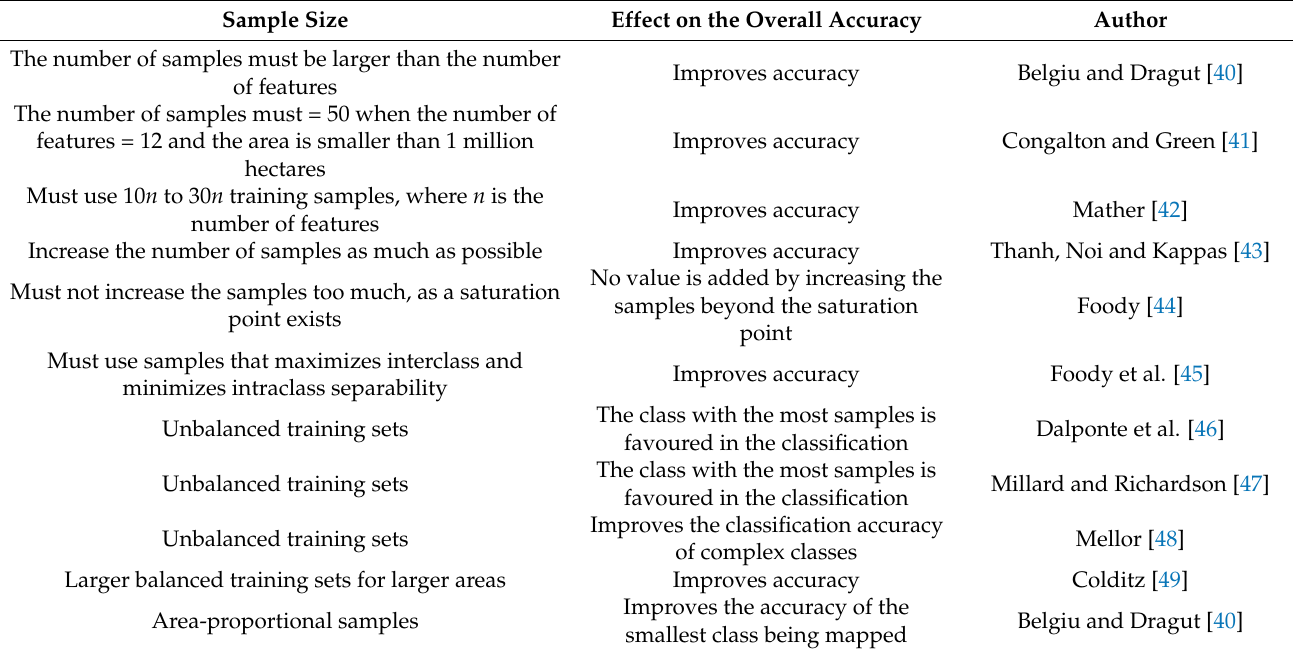
Table 1. Summary of the sample sizes and configurations used, along with their effects on the overall